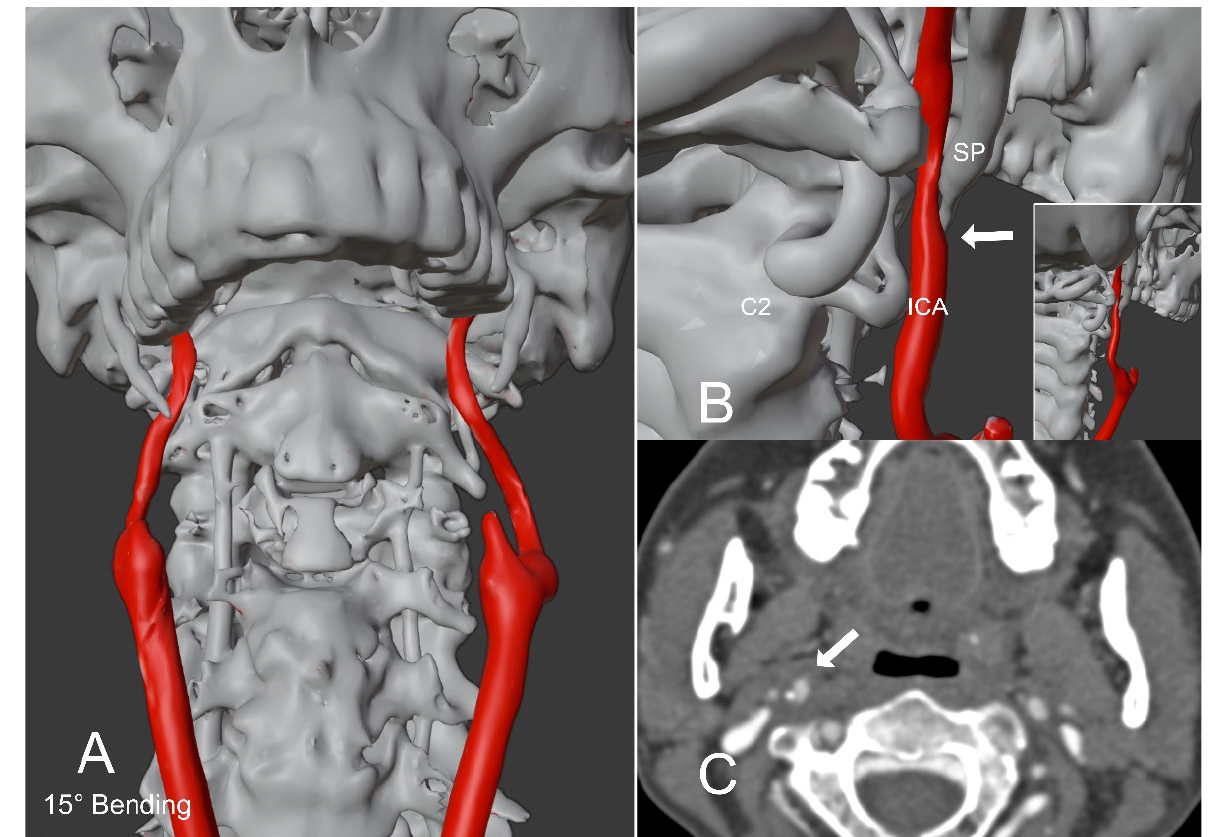
Figure 2. Patient with Eagle Syndrome in a flexed position of the head. ( A , B ) show a 3D reconstruction model of a patient with Eagle Syndrome in a flexed position of the head (15°). The model was created from the rest position CTA of the head and neck, applying a virtual bending of 15°. The right styloid process impinges the ipsilateral internal carotid artery tightening its caliber (arrow in ( B ). The enclosed image in ( B ) represents a postero-lateral perspective with a zoomed-out view. ( C ) shows the CTA image of the subject in a flexed position of the head (15°). The right styloid process impinges the ipsilateral internal carotid artery (arrow). SP = Styloid process; ICA = Internal carotid artery; C2 = C2 Vertebral body.